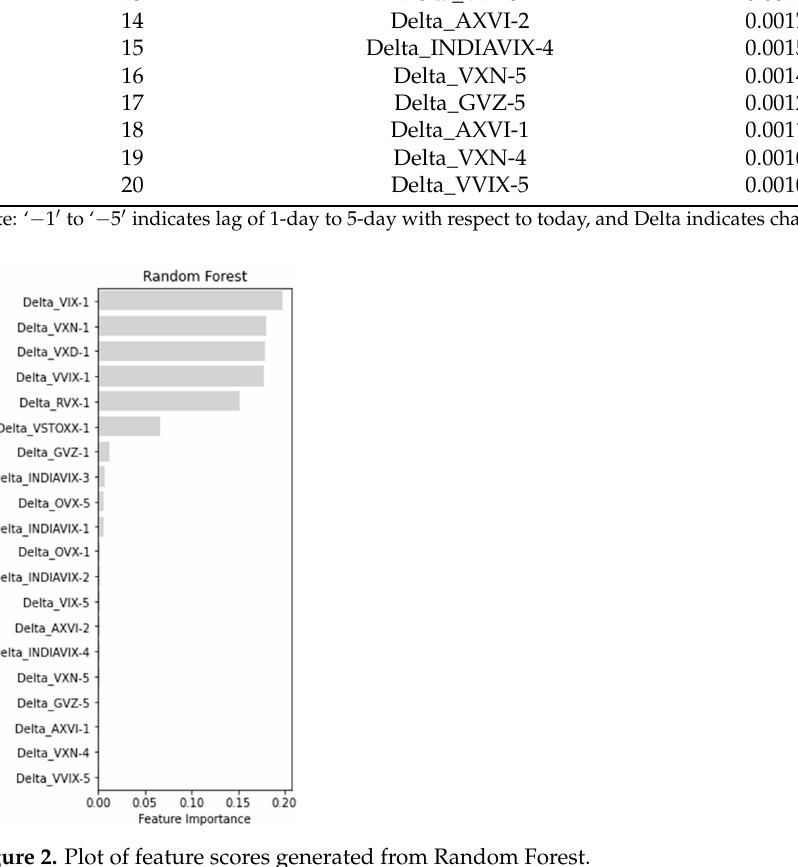
Figure 2. Plot of feature scores generated from Random Forest. Table 8. Feature coefficients generated from logistic regression.